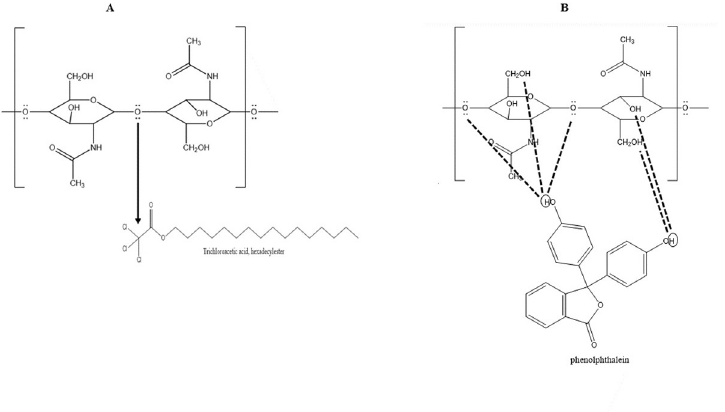
Fig 1. (A) Interaction of Trichloroacetic acid, hexadecylester with chitin where the central carbon attached to chlorine is highly deficient to the electron and can interact with the electron pair from chitin. (B) Interaction of P- xylenolpthalein with chitin by making hydrogen